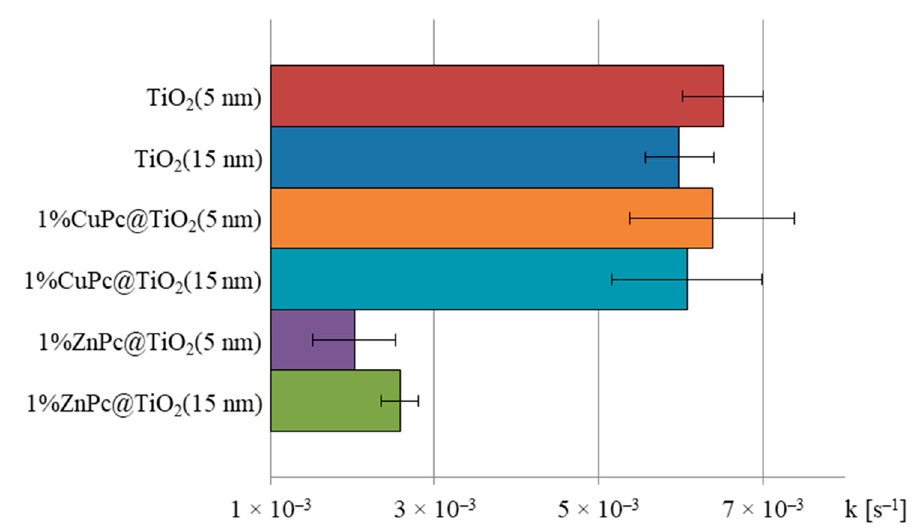
Figure 10. Comparison of degradation rate constants (k, s − 1 ) of IBU under UV irradiation with different photocatalysts. Table 4. The regression and kinetic parameters of IBU degradation rate constants (k, s -1 ) under UV